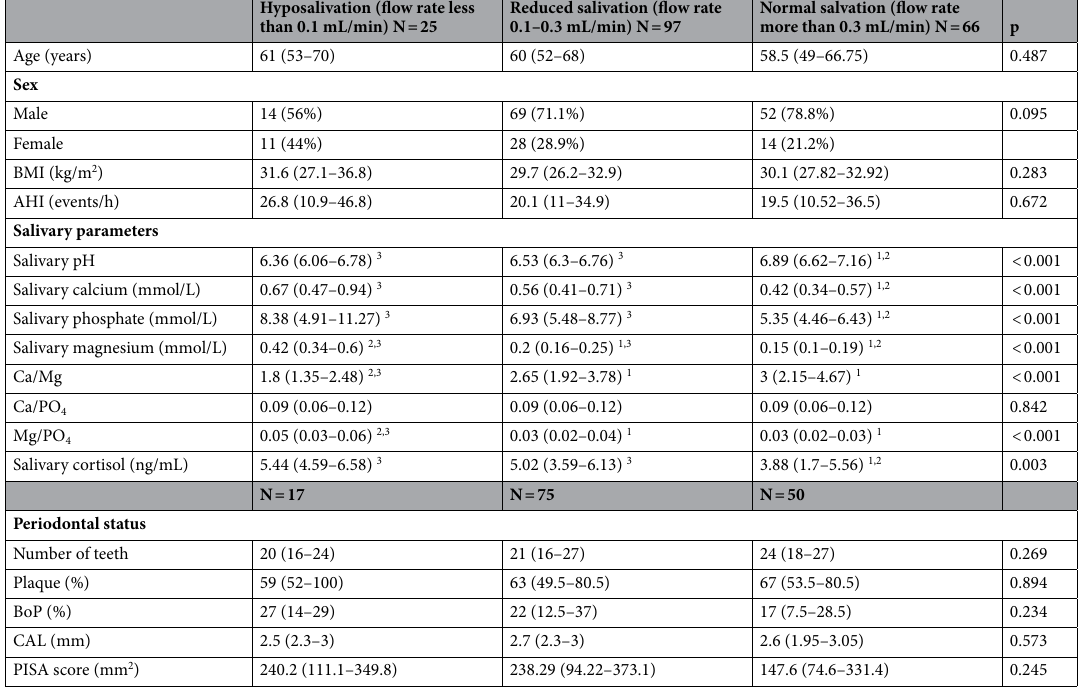
Table 3. Salivary and periodontal parameters according to salivary flow rate. Data are presented as the medians with interquartile ranges. The Kruskal ‒ Wallis test was used for group comparisons. 1 Post hoc difference significant to < 0.1 per group following the Mann ‒ Whitney U test. 2 Post hoc difference significant to 0.1–0.3 per group following Mann ‒ Whitney U test. 3 Post hoc difference significant to > 0.3 per group following Mann ‒ Whitney U test.